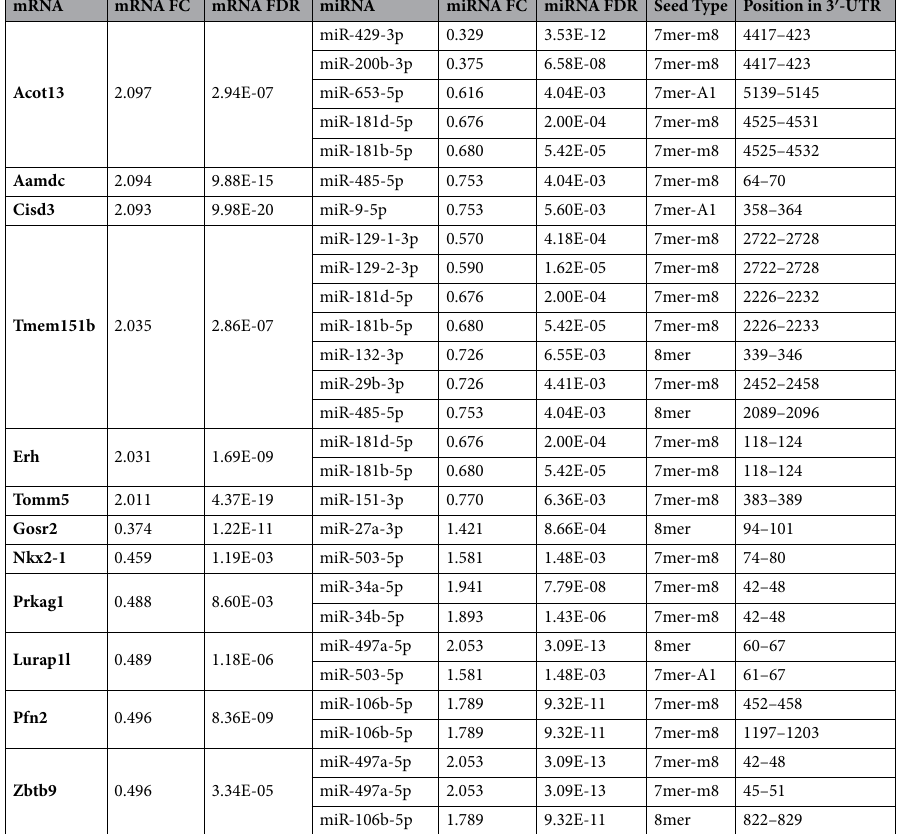
Table 1. Predicted miRNA targets differentially expressed in the IPN during acute nicotine withdrawal. TargetScan Mouse 7.1 predicted conserved MREs within the 3 ′ -UTRs of a subset of mRNAs differentially expressed in the IPN of NAWD mice compared to TA controls. miRNAs conserved in vertebrates and mammals that were inversely expressed (FDR < 0.01) and predicted to target these MREs are listed. Only mRNAs with a FC > 2 and an FDR < 0.01 were included in target prediction analysis. Seed type of the predicted MRE and its position within the 3 ′ -UTR are